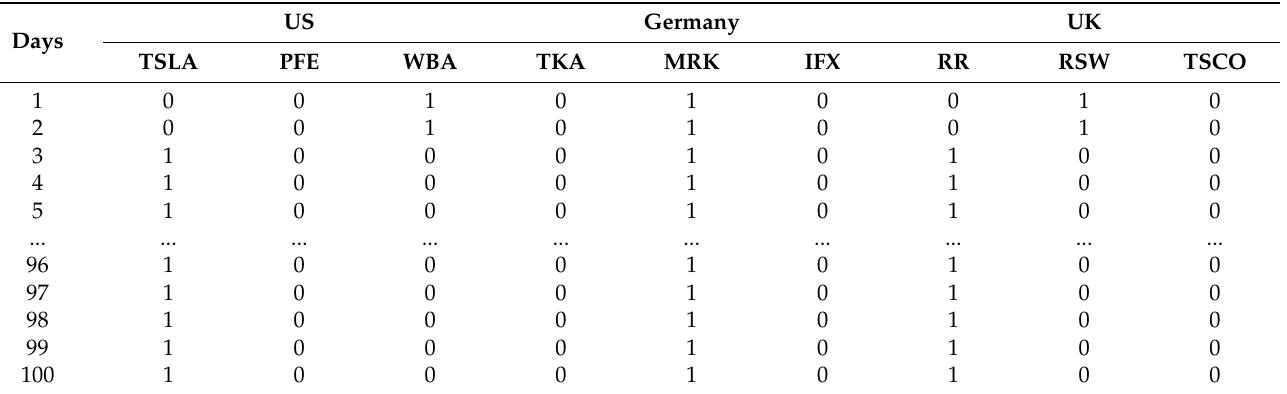
Table 1. Portfolio structures with 3 shares.